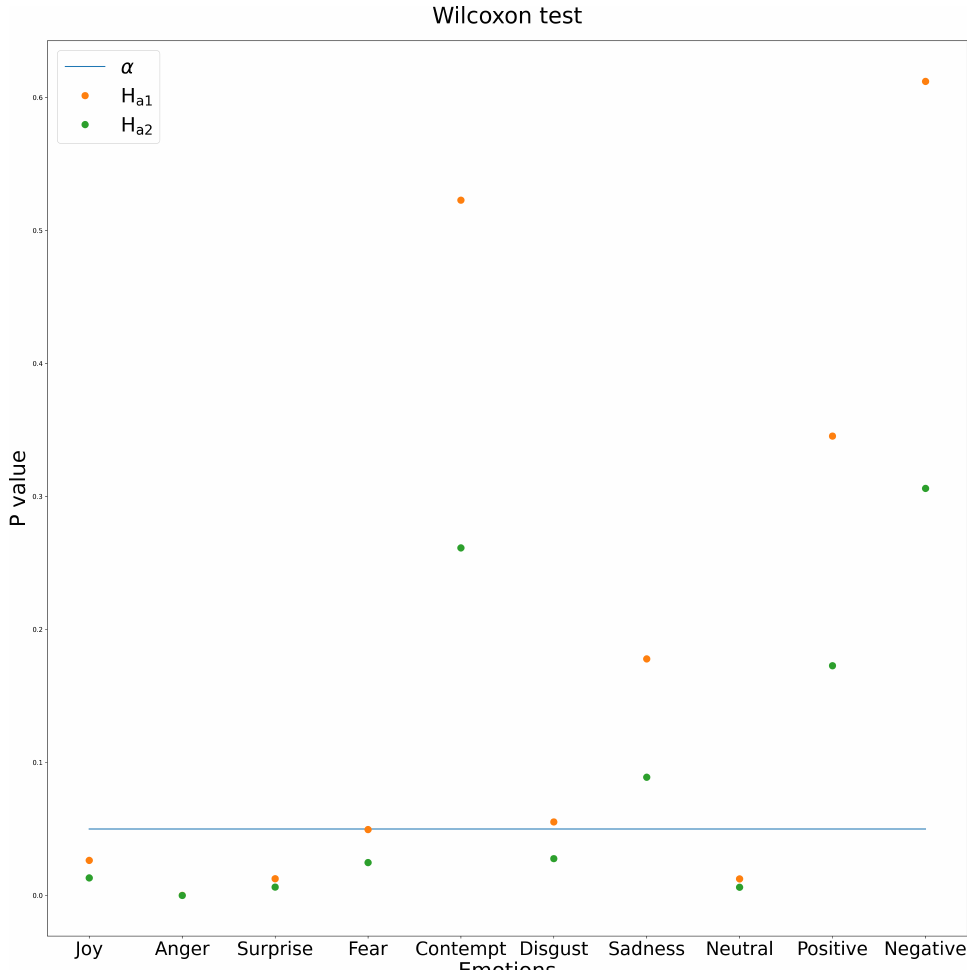
Figure 12. p value—obtained with the Wilcoxon signed-rank test—for both alternative hypotheses— the off-stimulus sample is different from the on-stimulus sample, denoted as µ 1 (cid:54) = µ 2 ( H a 1 ), and the off-stimulus sample is lower than the on-stimulus sample, denoted as µ 1 < µ 2 ( H a 2 )—for each emotion between samples of the dynamic web design—on-stimulus—and the static web design—off- stimulus—along with the significance level—horizontal